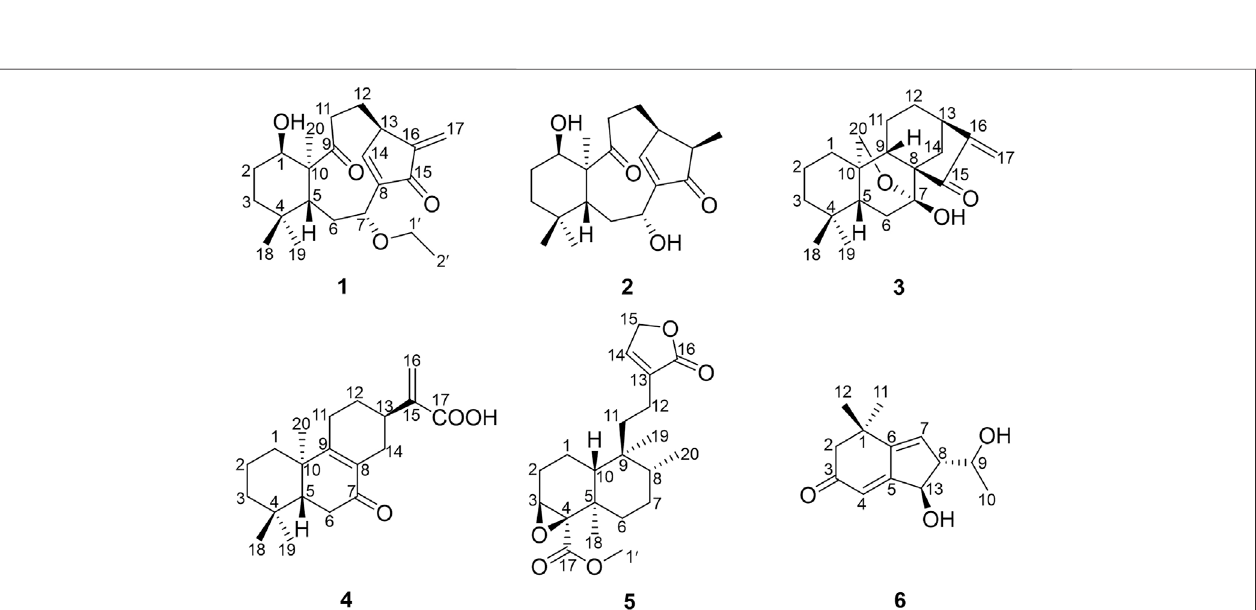
FIGURE 1 | Structures of compounds 1 – 6 isolated from Croton yanhuii.